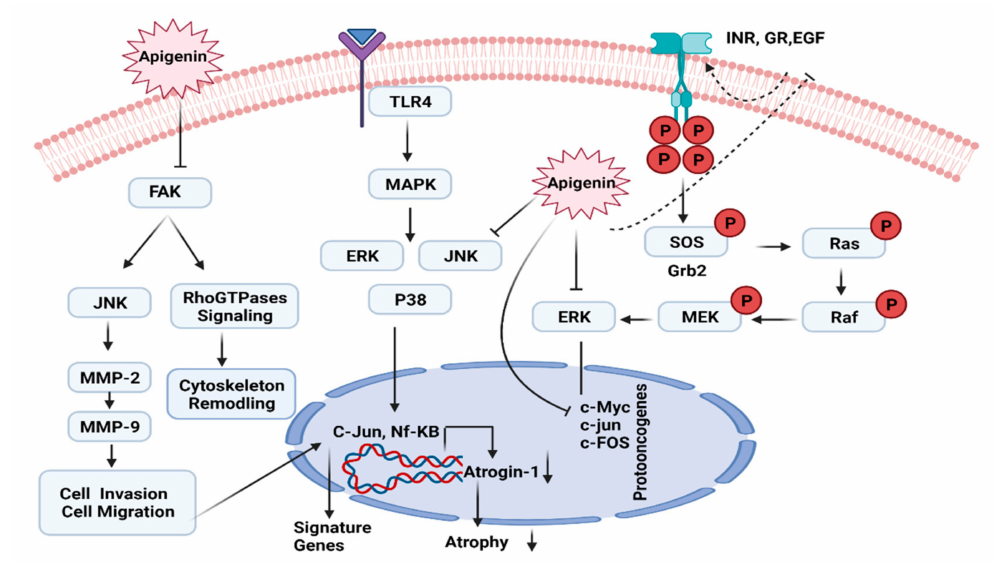
Figure 5. Inhibition of ERK/MAPK pathway by